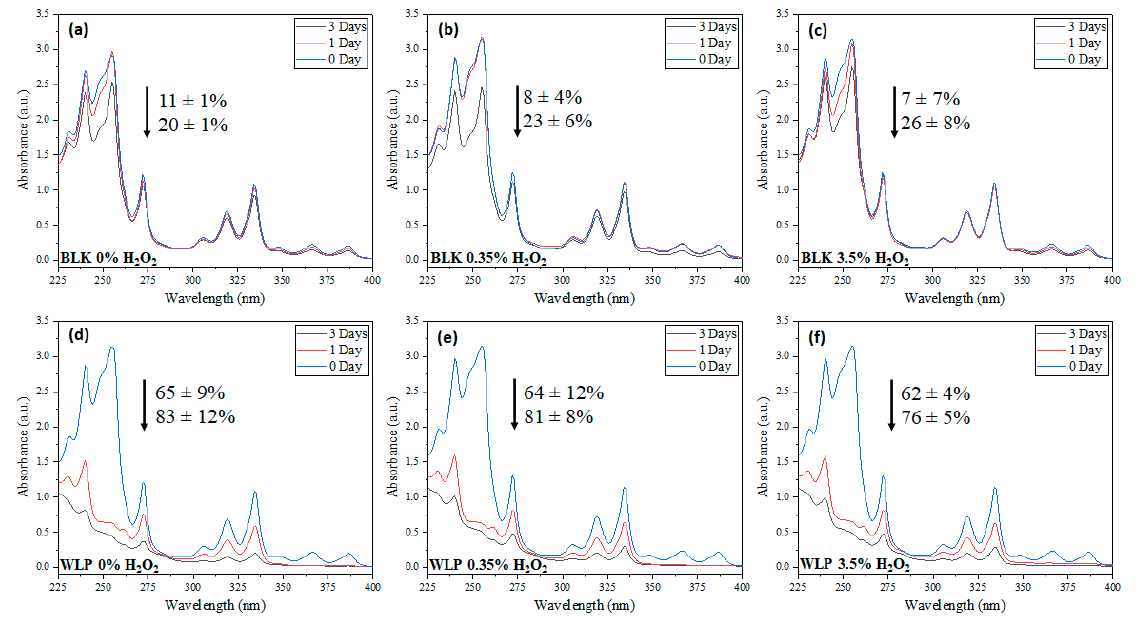
Figure 1. UV/VIS spectra of experiments performed in 1 and 3 days with ( a ) BLK 0% of H 2 O 2 , ( b ) BLK 0.35% of H 2 O 2 , ( c ) BLK 3.5% of H 2 O 2 , ( d ) WLP 0% of H 2 O 2 , ( e ) WLP 0.35% of H 2 O 2 , and ( f ) WLP 3.5% of H 2 O 2 .